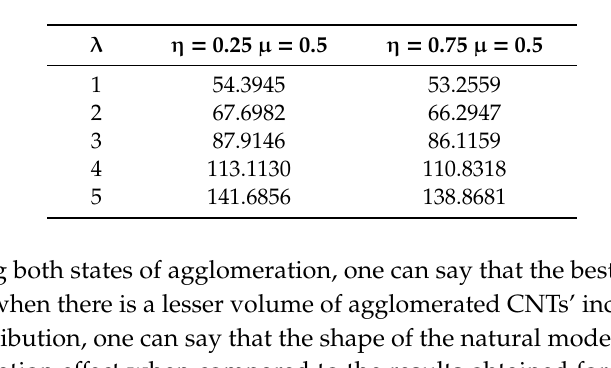
First five natural frequencies for the SFG distribution for two di ff erent states of partial